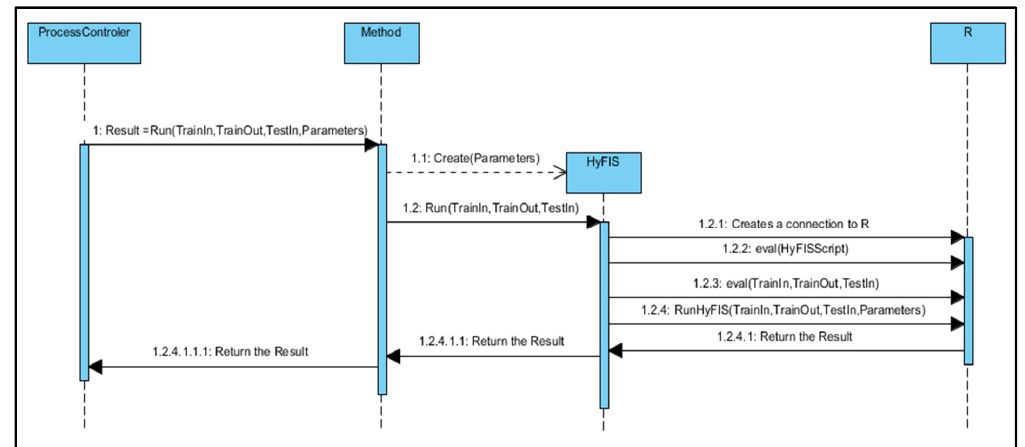
Figure 6. The sequence diagram in the case of using the HyFIS method.